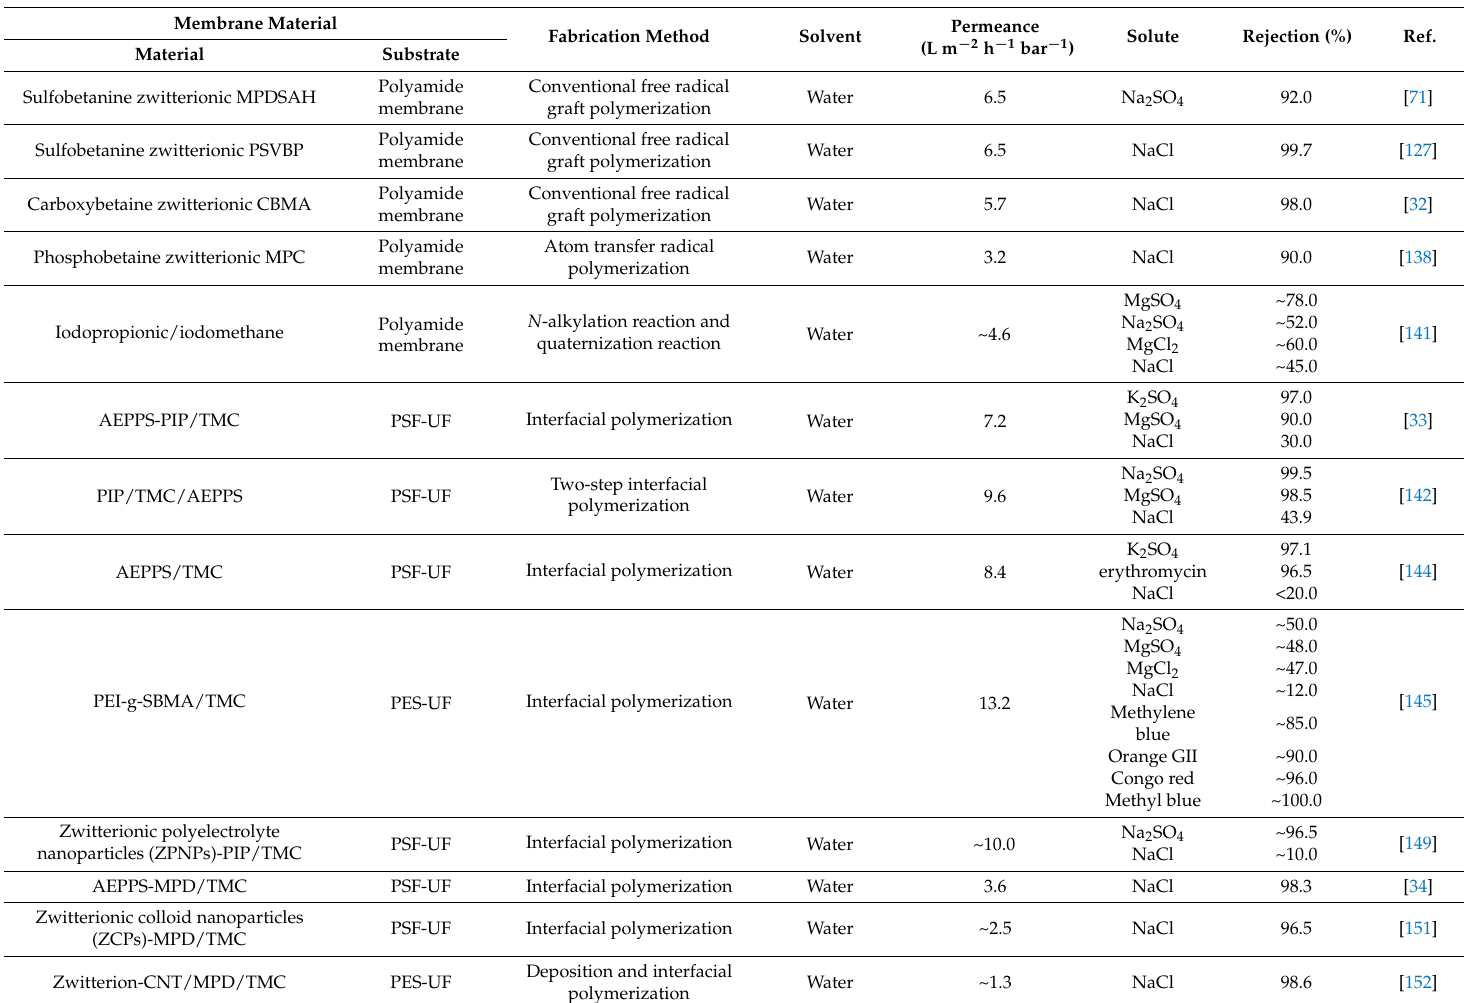
Table 2. Summary of materials, method, and performance of membranes containing zwitterionic ion